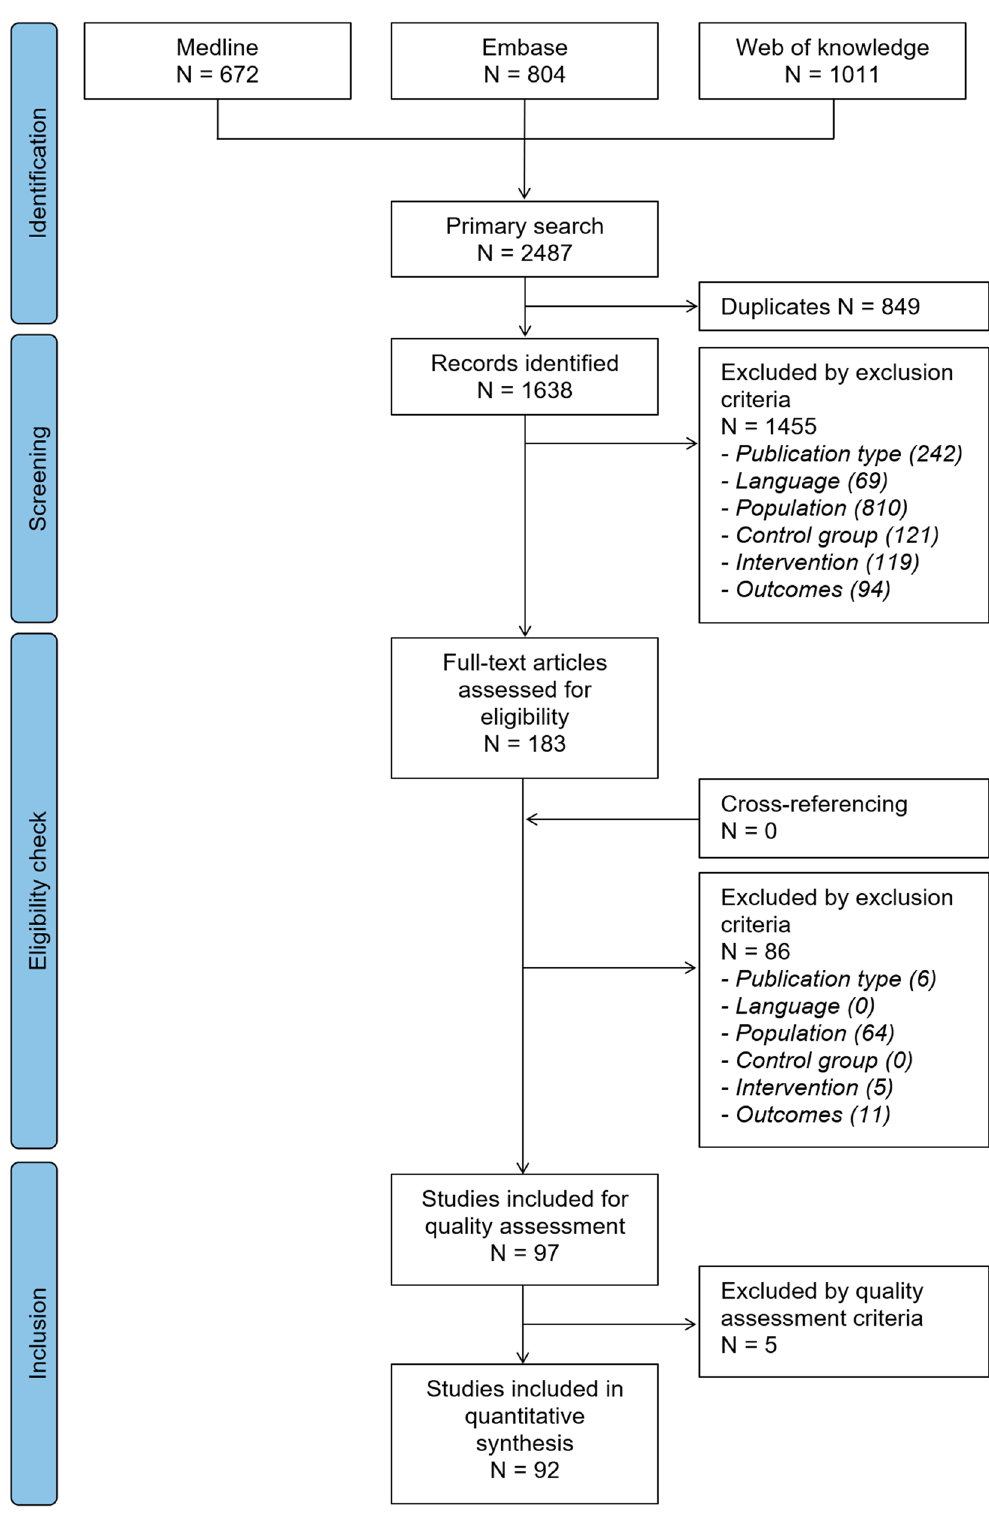
Figure 1. Flowchart of the search strategy conducted in this review (based on the PRISMA flowchart 47